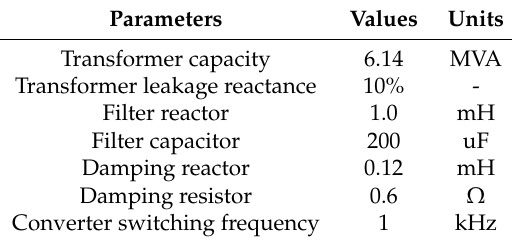
Table A2. Parameters of the harmonic filters.